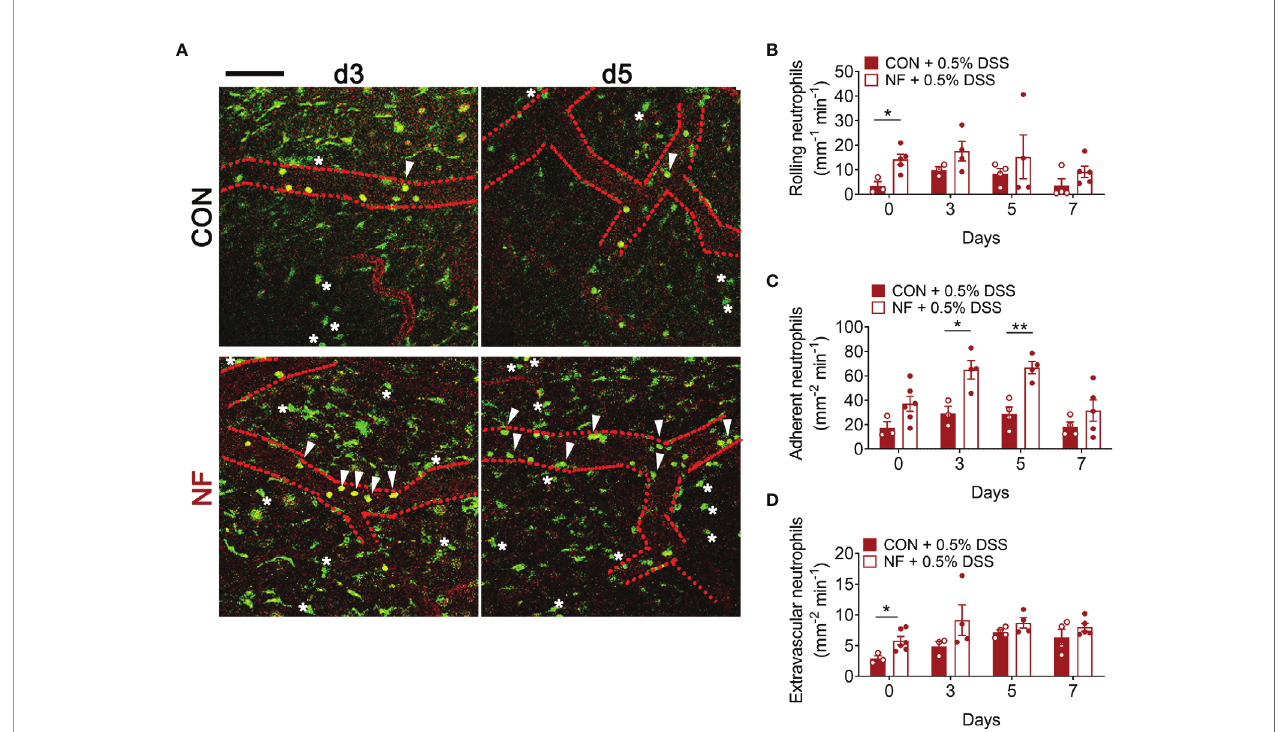
FIGURE 6 | No- fi ber feeding exacerbates neutrophil-endothelial interactions post-DSS. WT mice were fed either a control (CON) or no fi ber (NF) diet for 14 days prior to and during 7 days of 0.5% DSS-induced colitis. (A) At days 0, 3, 5, and 7 post-DSS, mice were anesthetized, injected with PE-conjugated anti-CD31 to label the endothelium, and intravital microscopy of the colon was performed. Scale bar = 100 µm. The number of (B) rolling, (C) adherent, and (D) extravascular neutrophils were enumerated. Data displayed as mean ± SEM. Dots represent individual mice, N ≥ 3 per group per timepoint, * P < 0.05, ** P < 0.01 with Student ’ s t